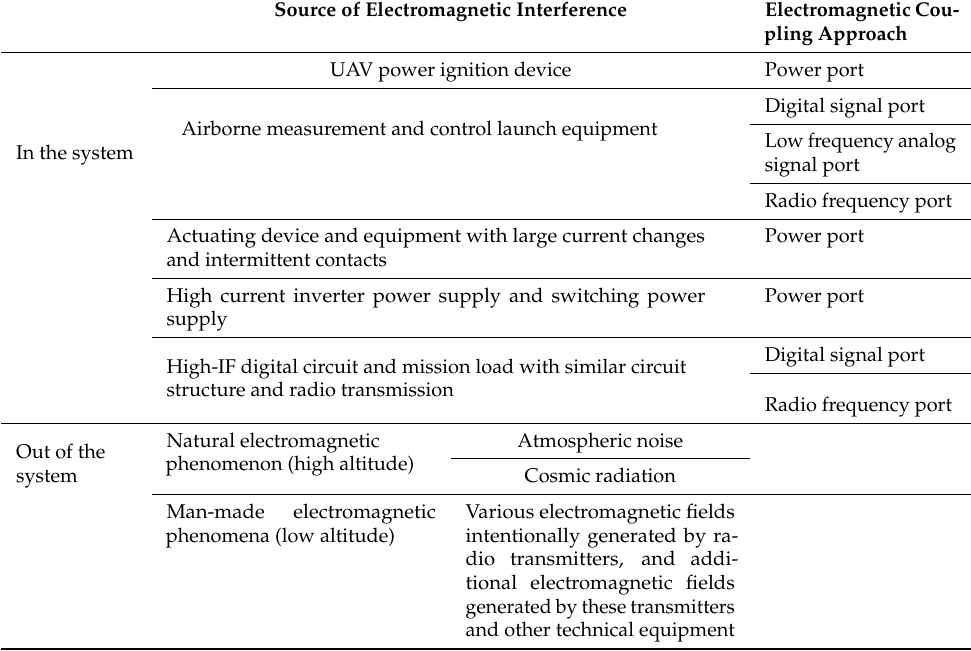
Table 1. The sources of UAV electromagnetic interference and coupling